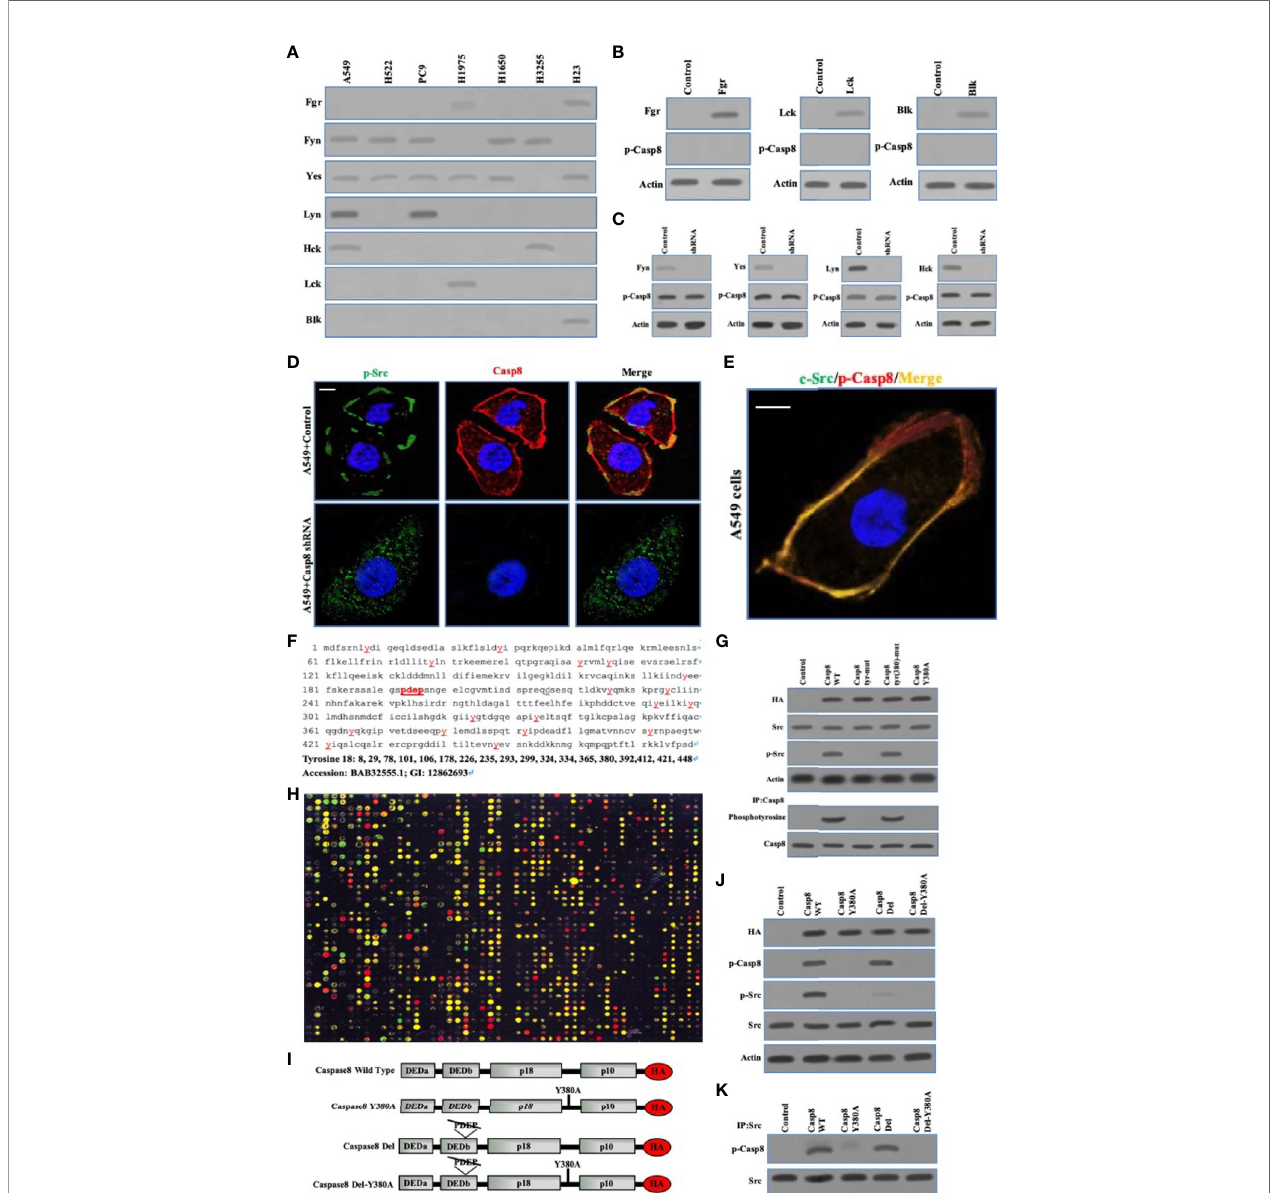
FIGURE 3 | Phosphorylated Caspase-8 by c-Src overactivated c-Src through its phosphotyrosine 380 and “ PDEP ” motif docking to SH2 and SH3 domain of c-Src. (A) Immunoblotting analysis of Fgr, Fyn, Yes, Lyn, Hck, Lck and Blk in lung adenocarcinoma cell lines including A549, H522, PC9, H1975, H1650, H3255 and H23 cells attached on fi bronectin for 24 h. (B) Immunoblotting analysis of Fgr, Lck, Blk and p-Casp8 in A549 cells transfected by adenoviral delivery of Fgr, Lck and Blk attached on fi bronectin for 24 h. (C) Immunoblotting analysis of Fyn, Yes, Lyn, Hck and p-Casp8 in A549 cells transfected by lentiviral delivery of shRNAs of Fyn, Yes, Lyn and Hck attached on fi bronectin for 24 h. (D, E) A549 cells were allowed to attach onto fi bronectin-coated dish for 24 h and assessed by confocal microscopy using antibodies against p-Src, Casp8, c-Src and p-Casp8. Scale bars, 10 m m. (F) The amino acid sequence and tyrosine position of Caspase-8. (G) Immunoblotting analysis of HA, p-Casp8, c-Src, p-Src and b -actin in H522 cells with adenovirus encoding control vector, Casp8 WT, Casp8 tyr-mut, Casp8 tyr (380)-mut and Casp8 Y380A attached on fi bronectin for 24 h. The TCLs of H522 cells with adenovirus encoding control vector, Casp8 WT, Casp8 tyr-mut, Casp8 tyr(380)-mut and Casp8 Y380A attached on fi bronectin for 24 h were subjected to immunoprecipitation (IP) using anti-Caspase-8 antibody. The blot was then stripped and reprobed for phosphotyrosine and Casp8. (H) Microarray analysis of SH2 domains of intracellular proteins binding to p-Casp8 in A549 cells. Green and yellow represented equal signal and downregulation; red represented upregulation. (I) Schematic representation of various HA-tagged mutants of Caspase-8. (J) Immunoblotting analysis of HA, p-Src, p-Casp8, c-Src and b -actin in H522 cells with adenovirus encoding Caspase-8 mutants attached on fi bronectin for 24 h. (K) The TCLs of H522 cells with adenovirus encoding Caspase-8 mutants in 3I were subjected to IP using anti-c-Src antibody. The blot was then stripped and reprobed for c-Src and